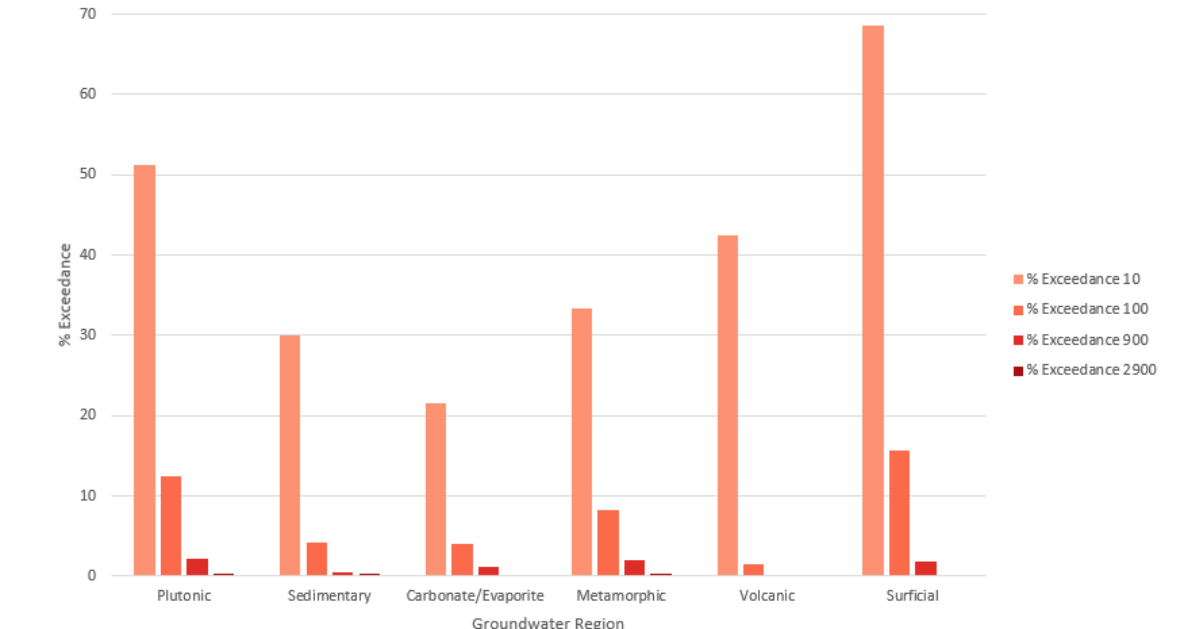
Figure 1. Percentage of samples in each groundwater region that exceed each aluminum threshold (10 µg/L, 100 µg/L, 900 µg/L, and 2900 µg/L).